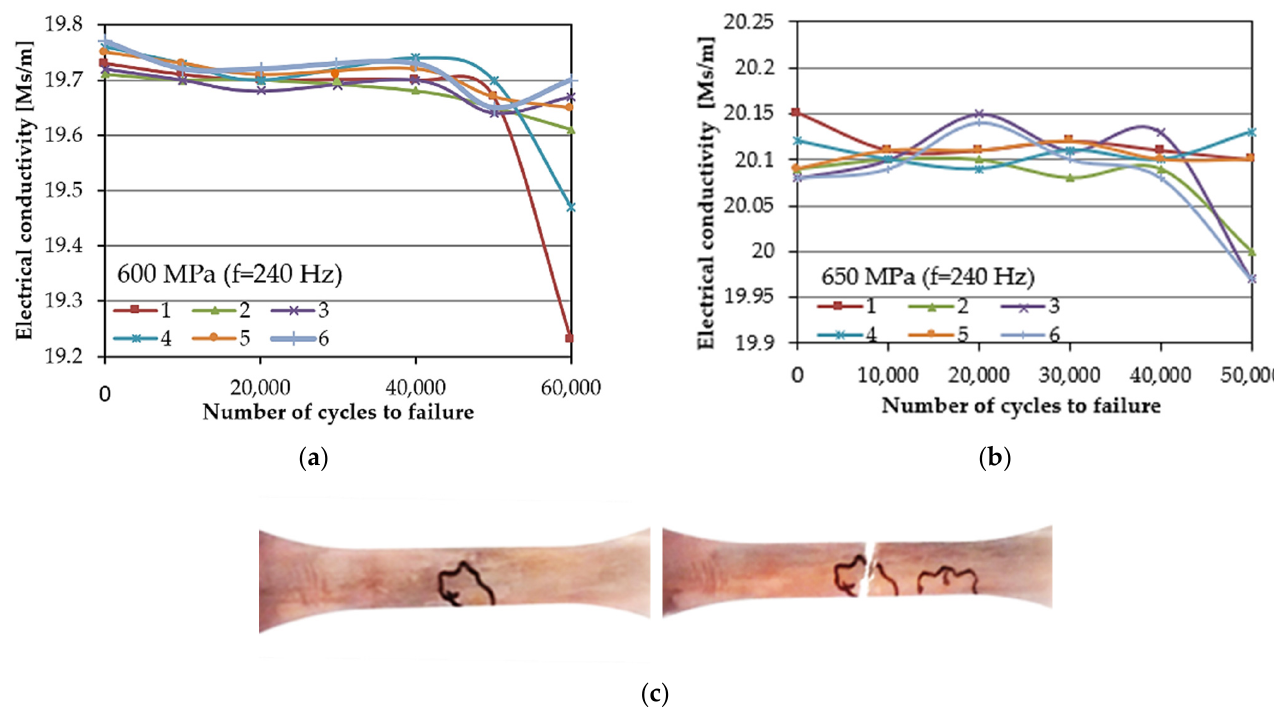
Figure 10. The exemplary results of electrical conductivity evolution measured in the selected loading cycles for two different levels of loading ( a , b ). Localized area of the potential crack and fracture of the specimen found after fatigue test ( c ).